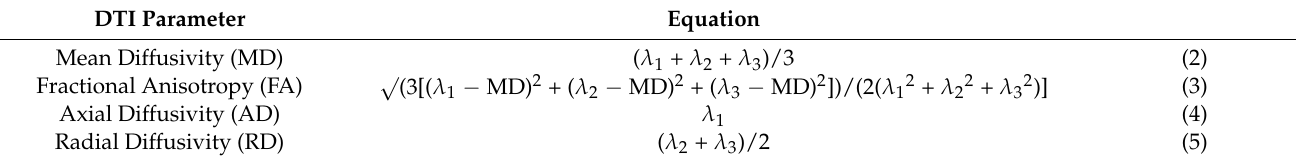
Table 1. Equations for deriving DTI parameters from the eigenvalues ( λ i ) in each imaging voxel. i = 1 represents the principal diffusion direction, while i = 2 and 3 correspond to the orthogonal diffusion directions perpendicular to the principal diffusion direction.